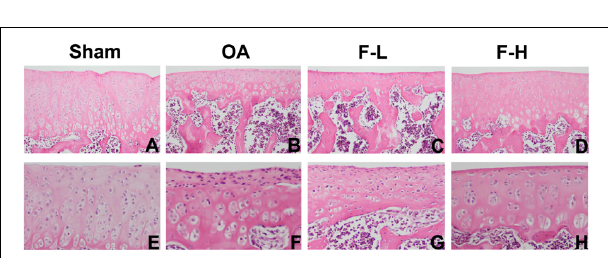
FIGURE 2 | Effects of FSGTC on the destruction of cartilage in OA rats assayed by HE staining. Rats were treated without (B,F) or with 200 mg/kg (C,G) and 400 mg/kg (D,H) of FSGTC before papain injection; sterile saline solution injection was used for the sham group (A,E) (original magnification × 100 or ×